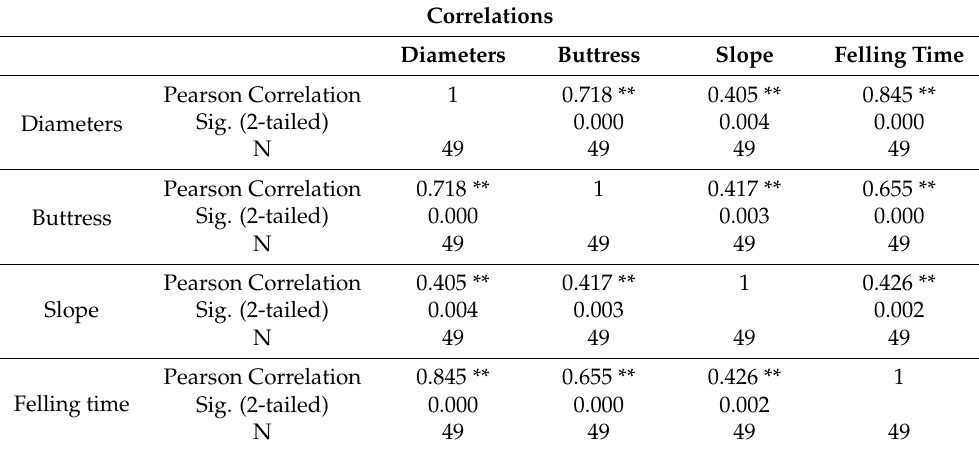
Table 3. Analysis of correlation among diameter, buttress, and slope to felling time.